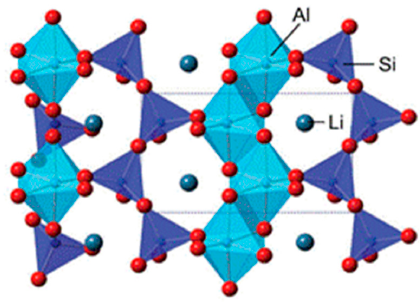
Figure 8. The crystallographic structure of spodumene.